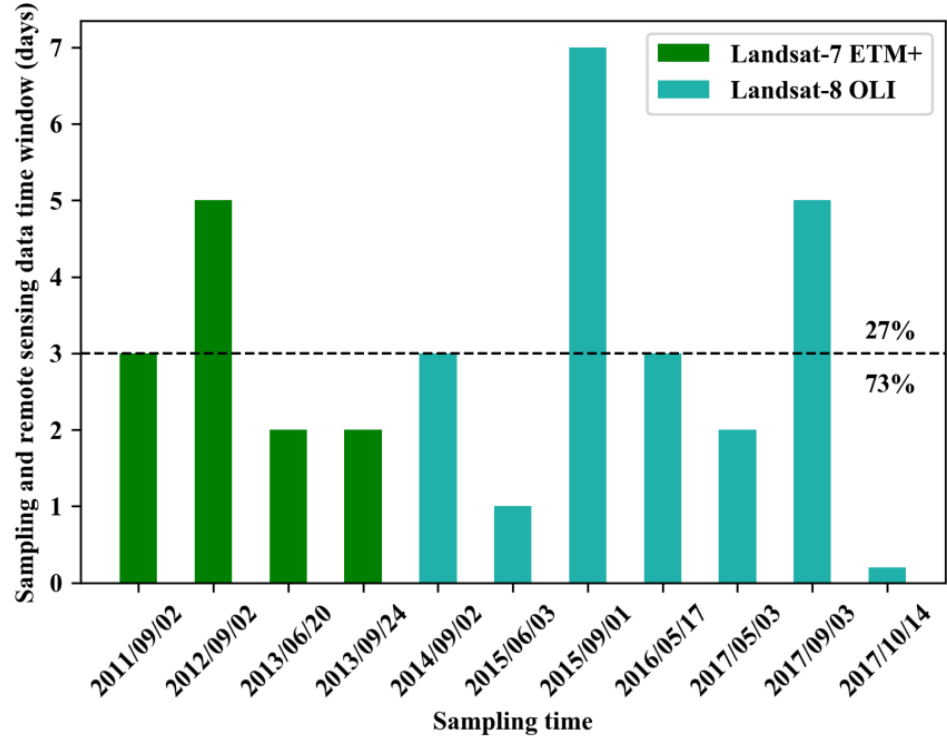
Figure 2. Ebinur Lake’s multitemporal Landsat dataset with sampling time window; 73% represents